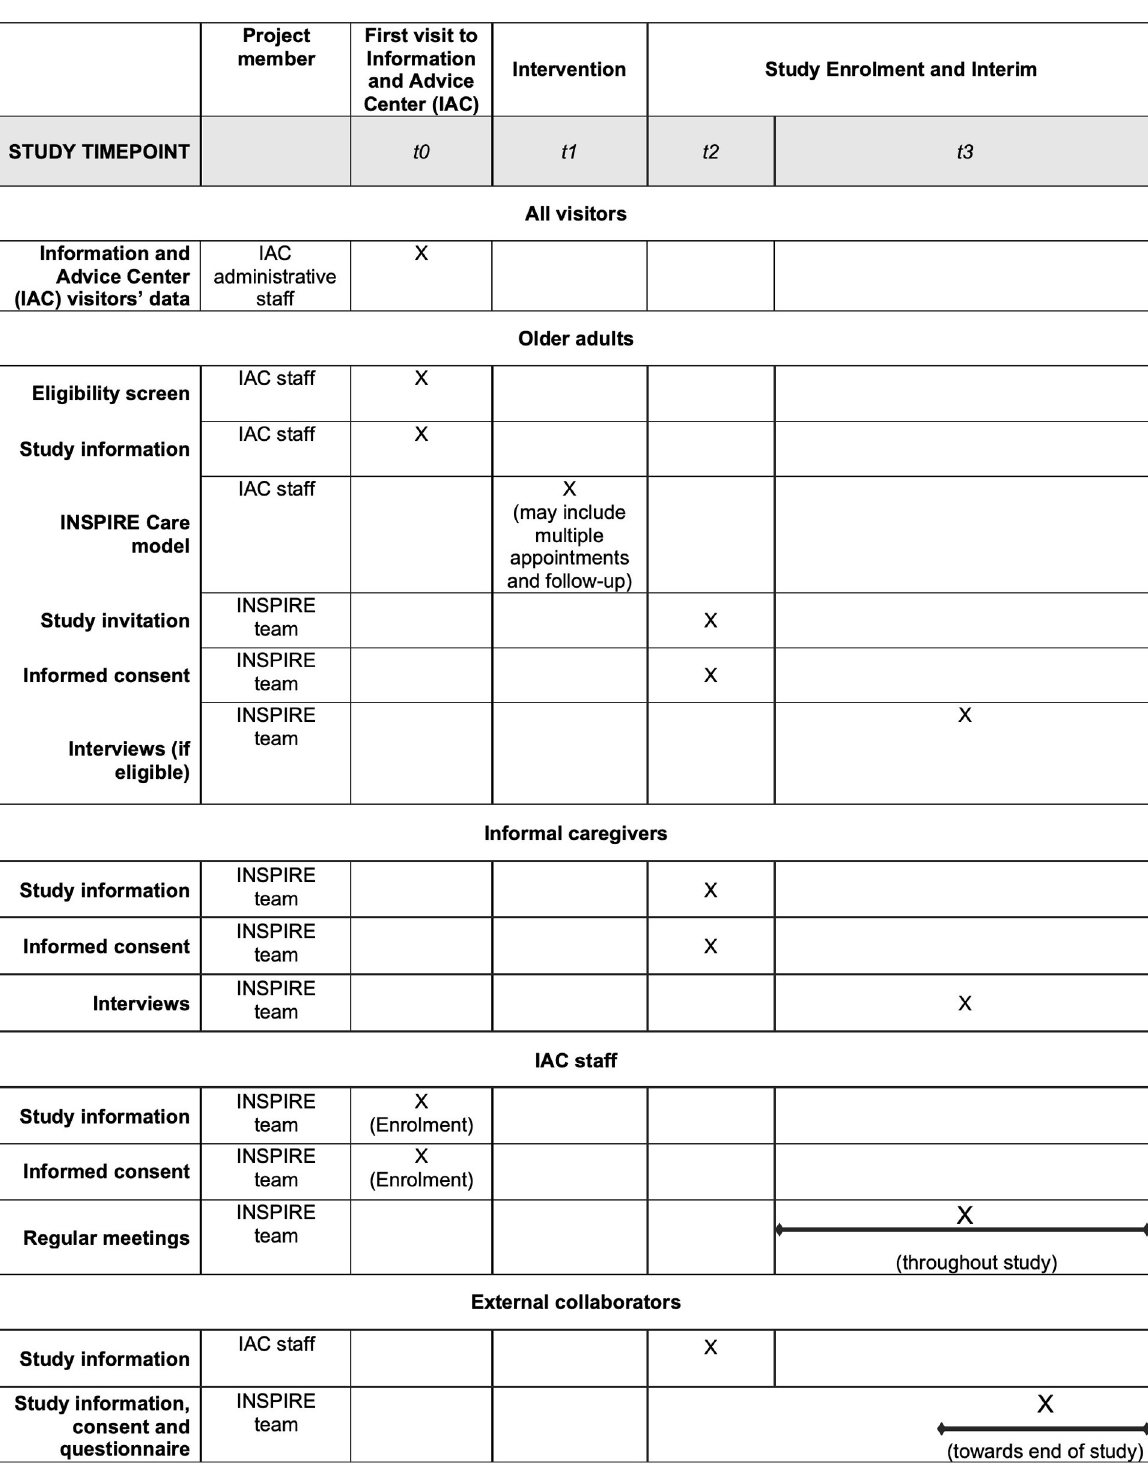
Fig 1. SPIRIT schedule of procedures. IAC = Information and Advice Center. T0 = opening of the new IAC; study enrolment of IAC staff; information collected about all IAC visitors; screening of older adults. T1 = intervention (usual care at the new IAC) which takes place regardless of whether older adults participate in the study. T2 = enrolment of eligible older adults and their informal caregivers as identified in t1. T3 = interviews of participating older adults and informal caregivers; meetings with IAC staff throughout study; survey of external collaborators.